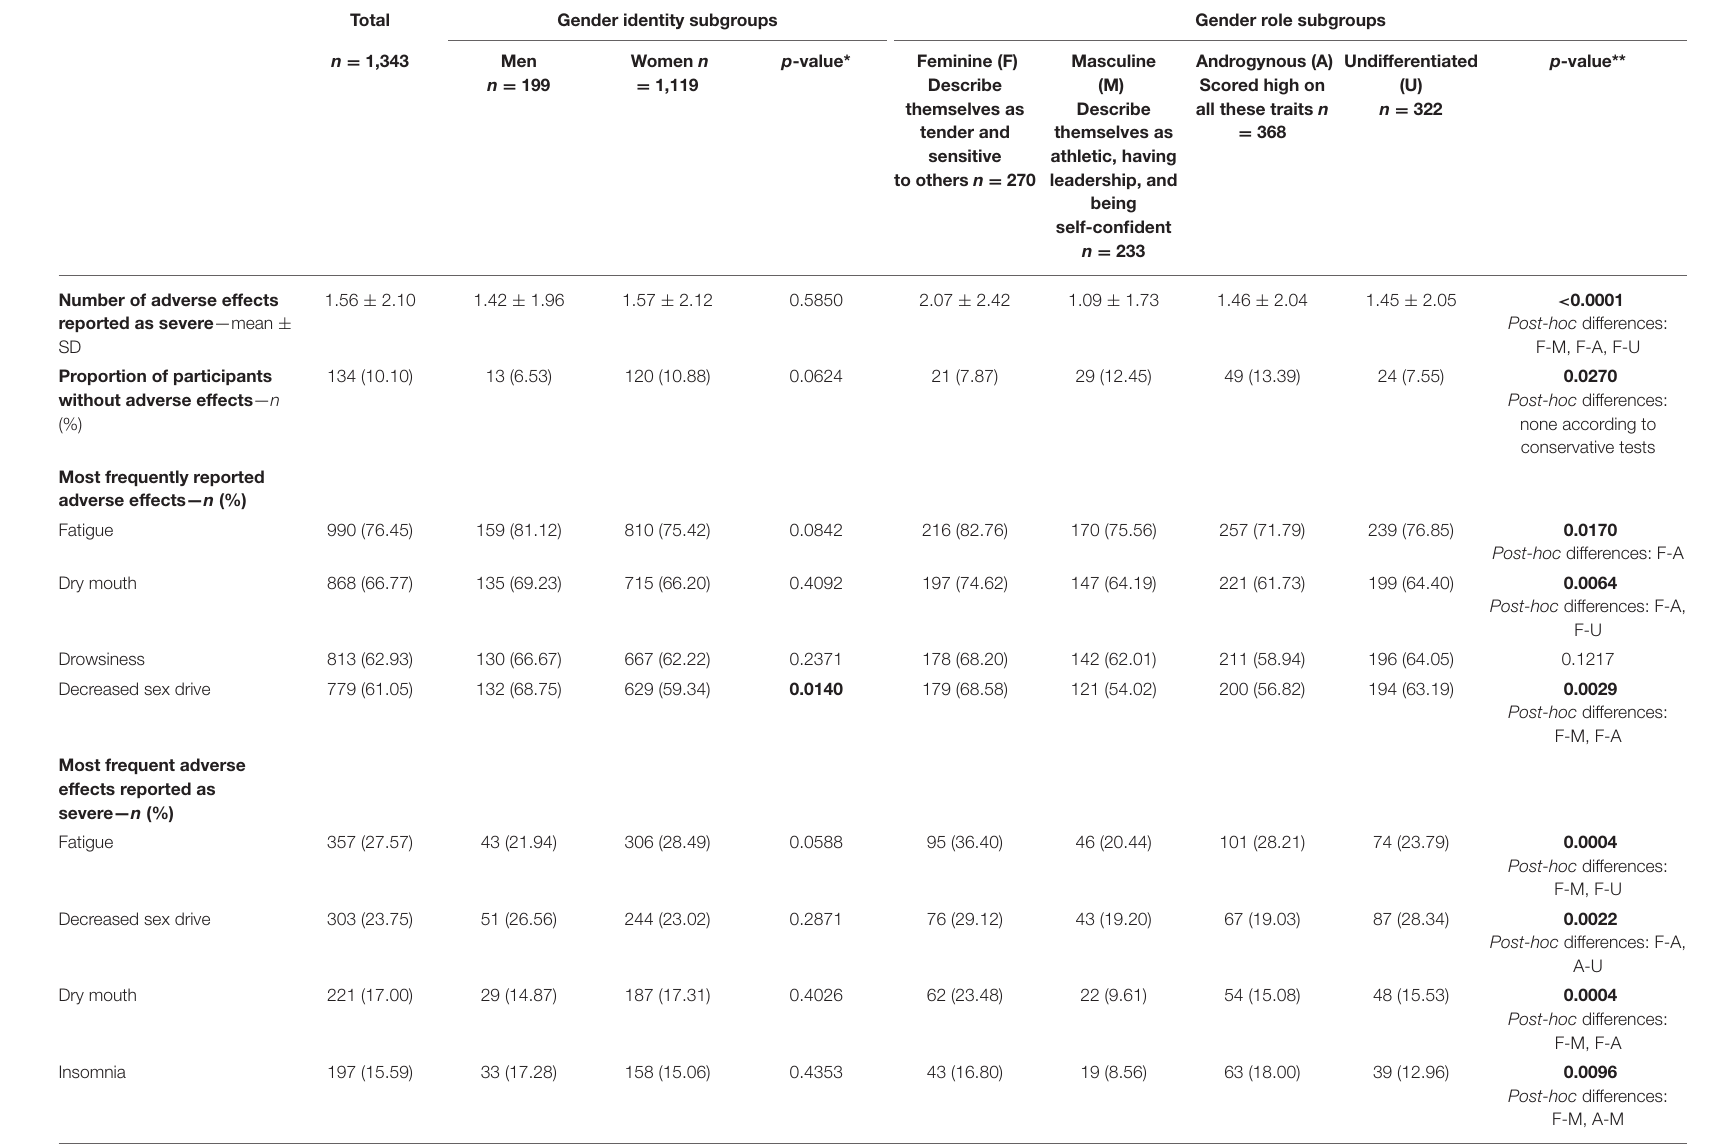
TABLE 2 | Number of adverse effects reported as severe and most frequently reported adverse effects according to gender identity and gender role